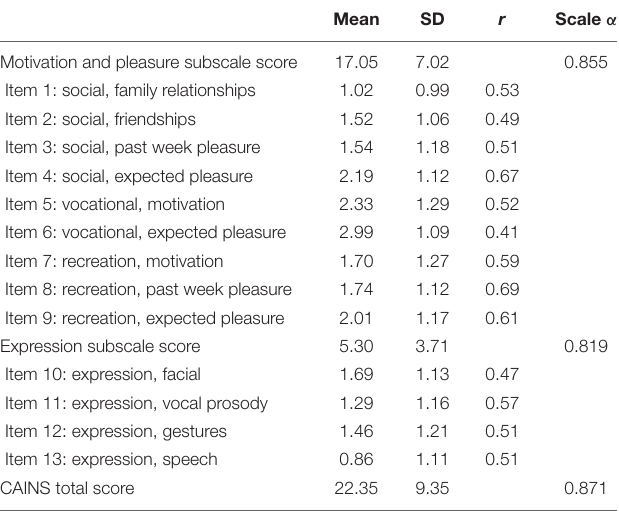
TABLE 2 | Internal consistency of CAINS item and subscale scores ( n =